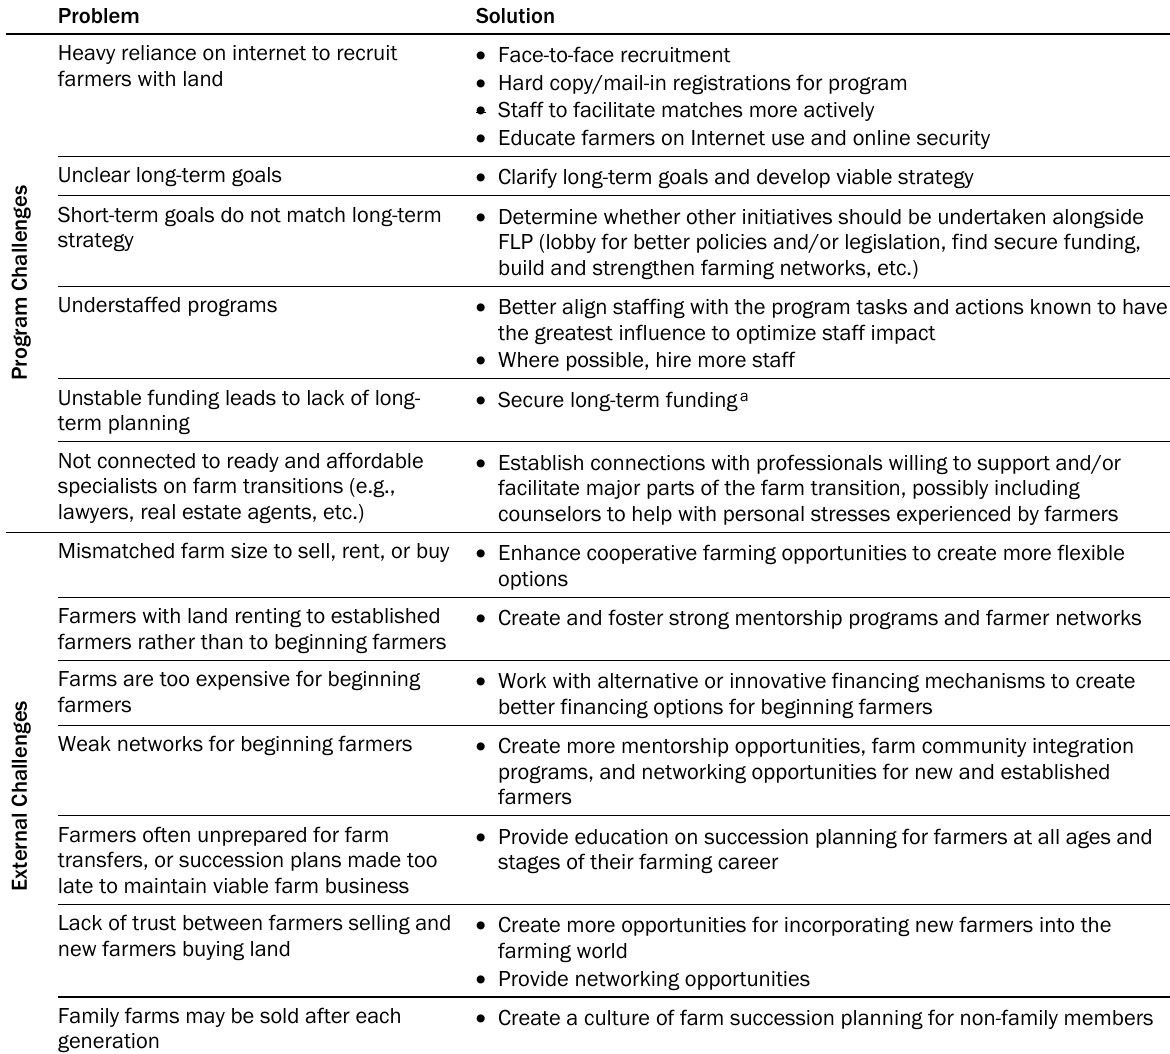
Table 4. FLPs: Existing Problems and Potential